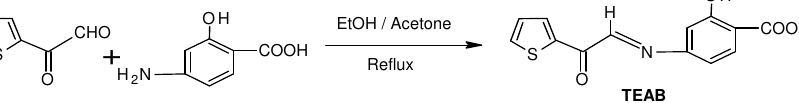
Figure 1. Synthesis of TEAB.